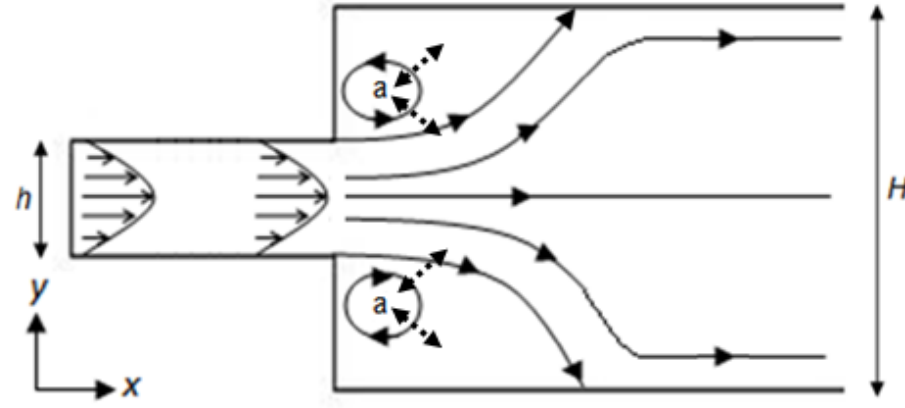
Figure 2. Schematic plan view of laminar flow in an open channel with a sudden expansion in width, where eddies (a) have developed. Solid arrows indicate direction of advective transport from the inlet to the outlet. Analyte transport from within developed eddies occurs only through diffusion, as indicated by broken-line arrows. Adapted from Acrivos and Schrader